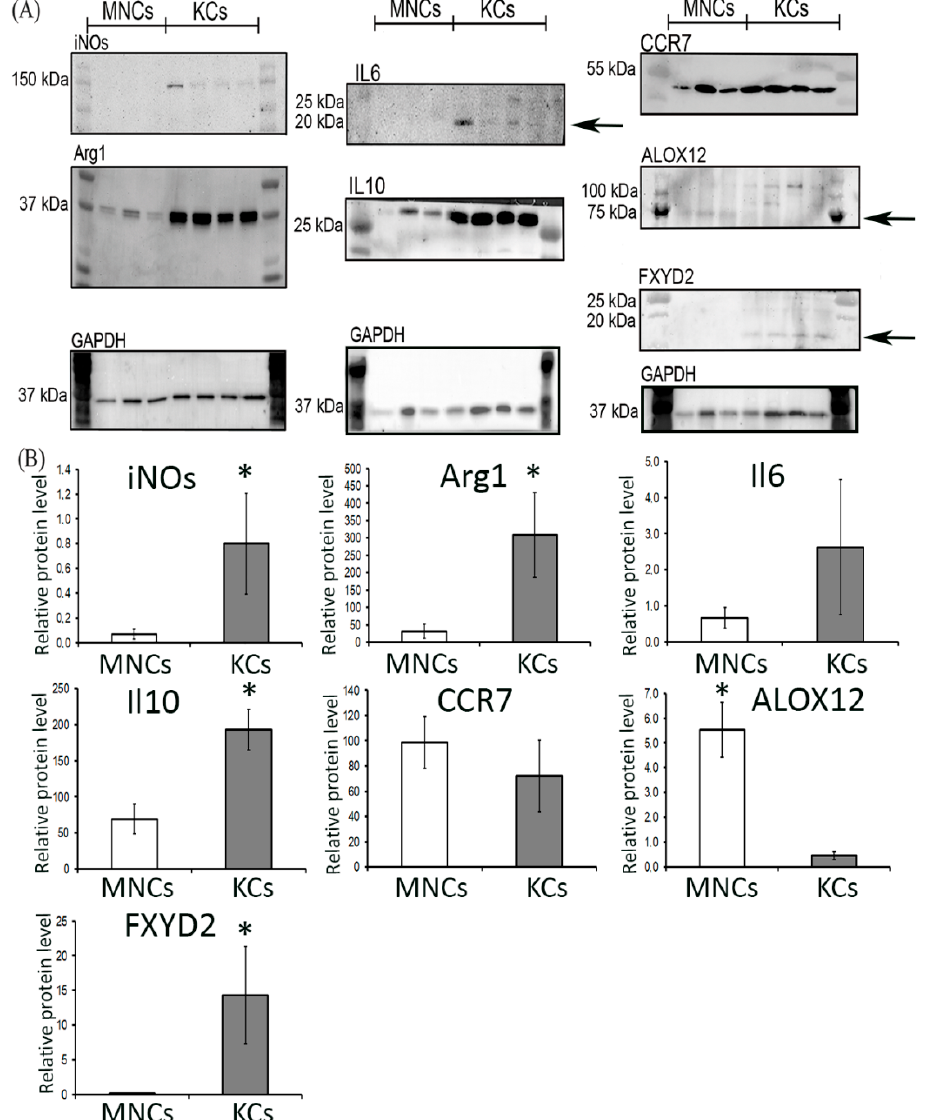
Figure 5. Relative protein levels of iNOs, IL6, IL10, CCR7, and Arg1 revealed by Western-Blot analysis. Representative Western-Blot membranes are shown in the panel ( A ), full-size membranes are shown in Figures S5 and S6. Visual assessment of the western blot membranes was followed by quantitative densitometry ( B ). The data is listed as mean ± standard deviation. * p < 0.05 monocytes vs Kupffer cells. KCs: Kupffer cells; MNCs: monocytes.